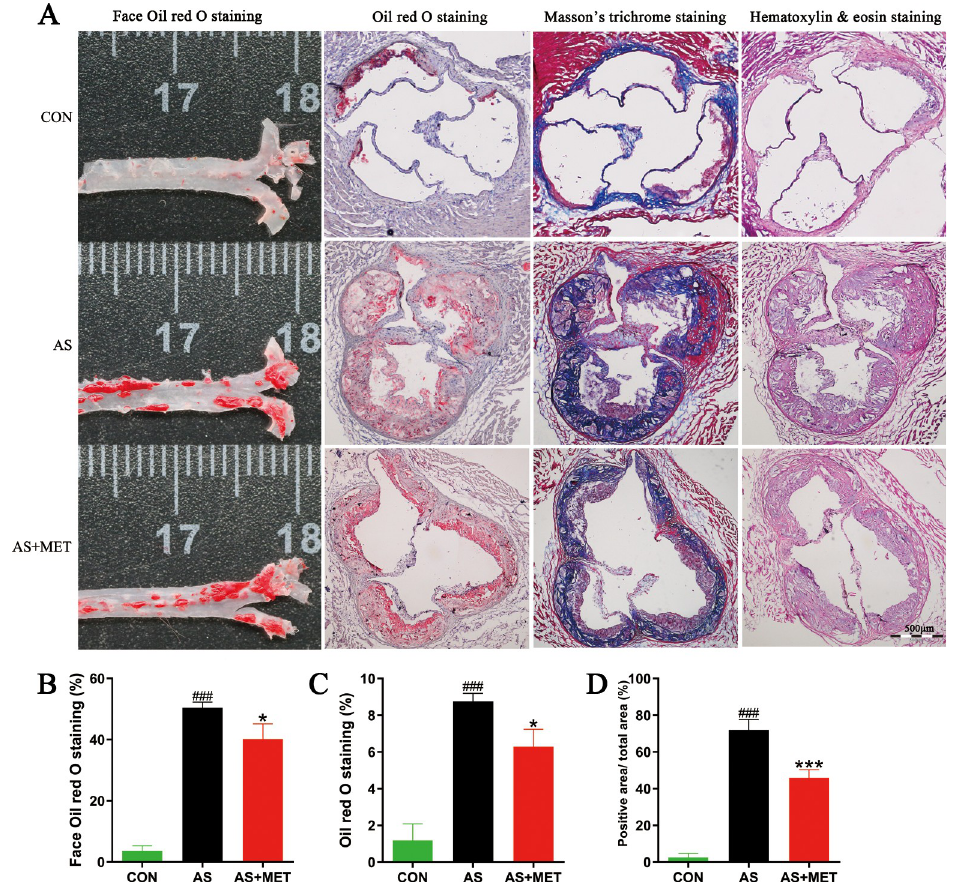
Fig 2. Effects of MET administration on the pathological lesions in atherosclerotic ApoE -/- mice. (A) Representative sections of the valve area of the aortic root of the heart were stained with face oil red O staining; oil red O staining; Masson’s trichrome staining and hematoxylin&eosin staining; respectively. Quantitative analysis as lesion area/total area (%) shown in face oil red O staining ( B ); oil red O staining ( C ); and Masson’s trichrome staining ( D ); # (CON vs. AS): # p < 0.05, ## p < 0.01, ### p < 0.001. � (AS vs. AS+MET): � p < 0.05, �� p < 0.01, ��� p < 0.001. Original magnification, × 40. The bar of 500 μ m was presented in the right corner of Fig 2A .